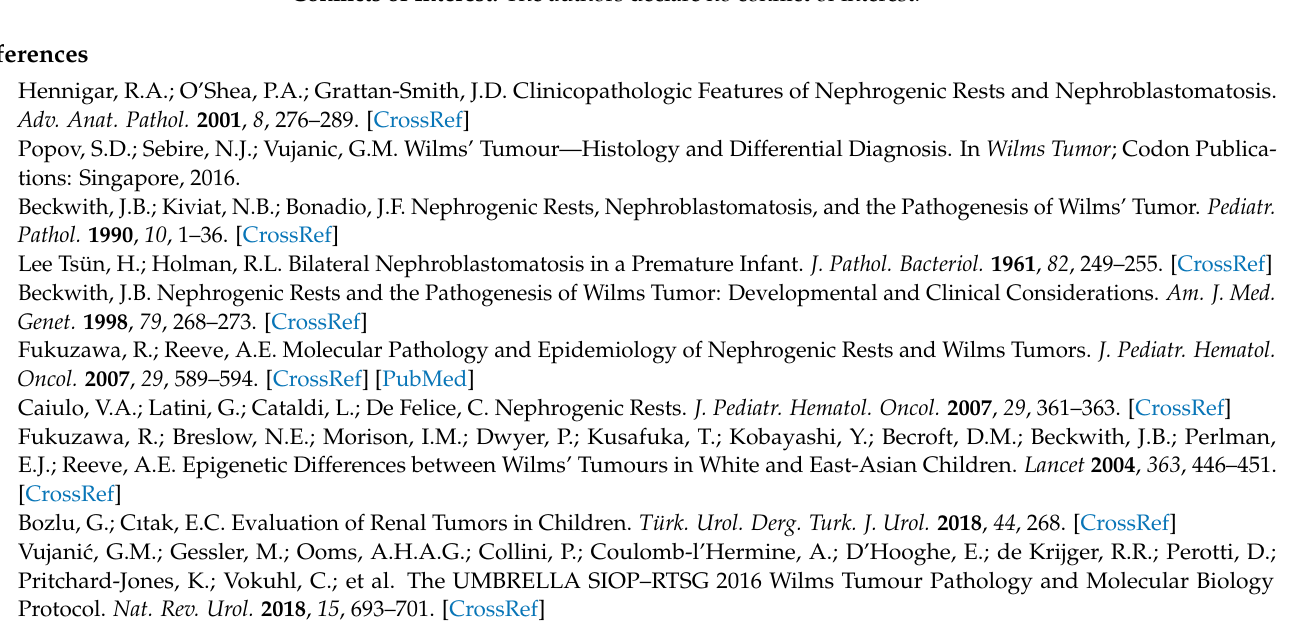
Table S2a: “Standards for Reporting Diagnostic Accuracy 2015” (STARD 2015) checklist, Table S2b: Case report guidelines (CARE checklist 2013), Table S3a: Quality assessment of 18 out of 23 included articles based on the STARD 2015 checklist, Table S3b: Quality assessment of 5 out of 23 included articles based on the CARE 2013